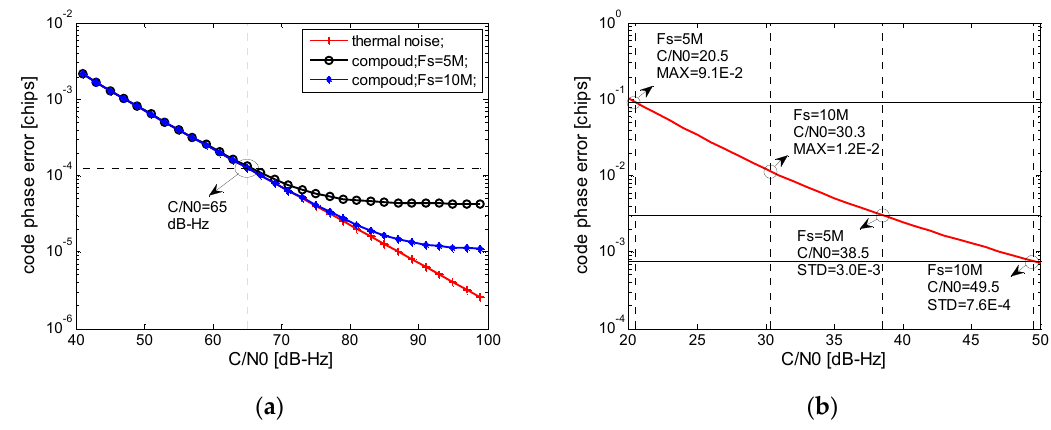
F = 1.023 MHz, F = 2.046 MHz, c sc